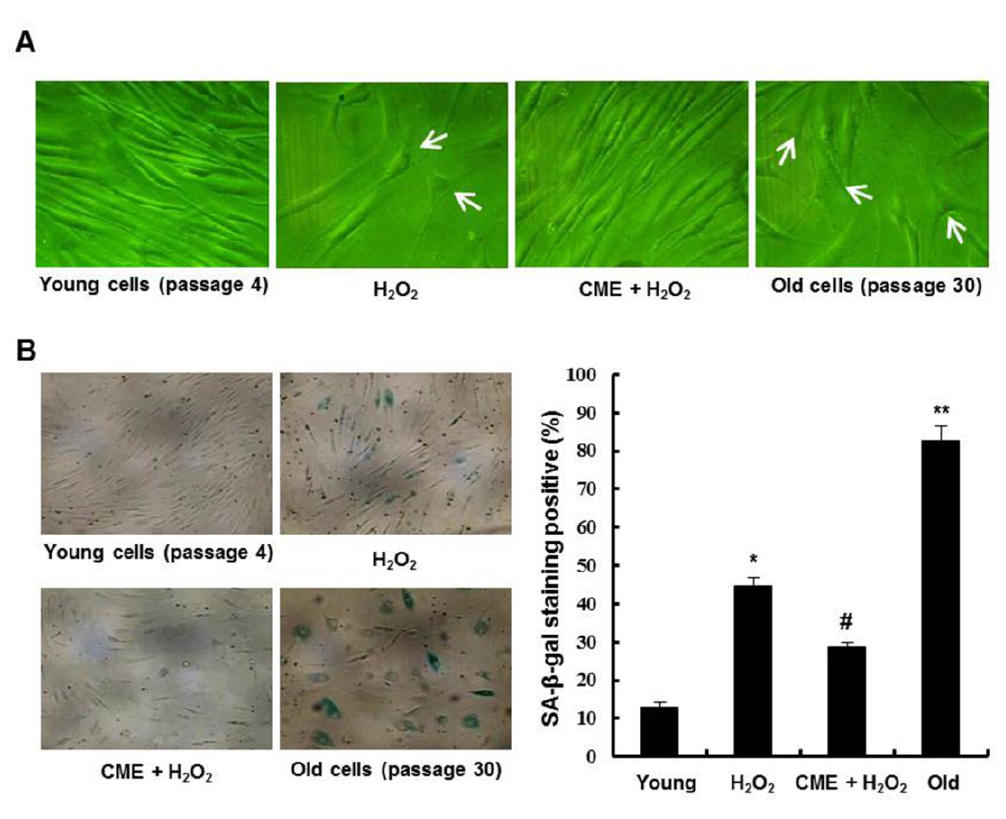
Figure 6. Inhibitory effect of CME on oxidative stress-induced premature senescence in HDFs. The cells were treated with 0.8 mM H 2 O 2 for 3 h in the presence or absence of 100 μg/mL of CME and then recovered for 7 days with fresh medium. ( A ) Morphological observation of cells was undertaken via optical microscopy. Magnification: 200×. ( B ) Representative micrographs of young cells (passage 4), 0.8 mM H 2 O 2 -induced premature senescent cells, CME-treated cells, and old cells (passage 30) after senescence-associated β-galactosidase (SA-β-gal) staining. Magnification: 100×. The percentage of SA-β-gal positive cells was quantified (right graph). Data represents the mean ± SE of three independent experiments. The significance of differences as compared with the young cells group ( * p < 0.05, ** p < 0.01) and the H 2 O 2 alone group ( # p < 0.05) were assessed using Student’s t